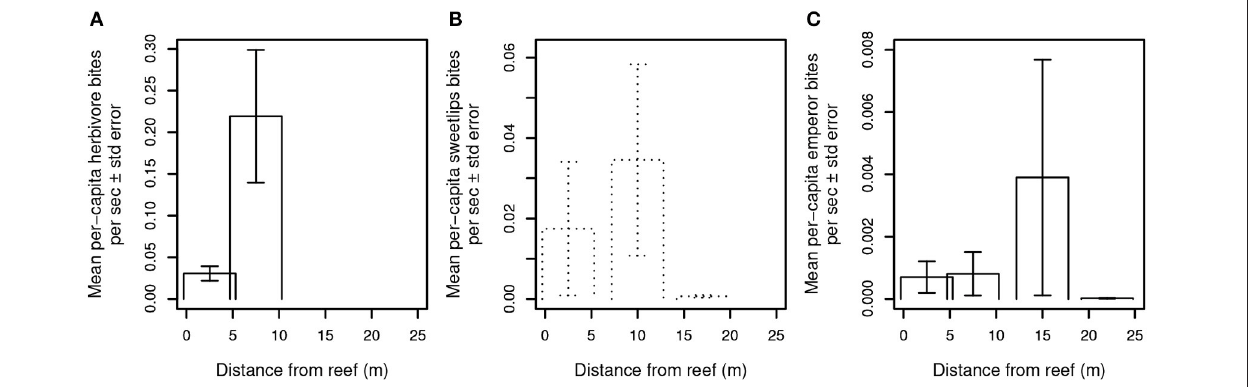
FIGURE 4 | Per capita bite rates of herbivores and bioturbating fishes. Bite rates are calculated per second of video footage for (A) herbivores, (B) sweetlips, and (C) emperors. Daytime observations are indicated with solid lines and dusk/night with dotted lines. No herbivores were observed in the dusk/night videos, and no feeding by sweetlips occurred in the daytime videos. In the dusk/night videos, emperors were seen taking a total of nine bites at the intermediate-distance camera on a single patch reef, and a total of three non-feeding emperors were recorded at the near and far cameras on other reefs.